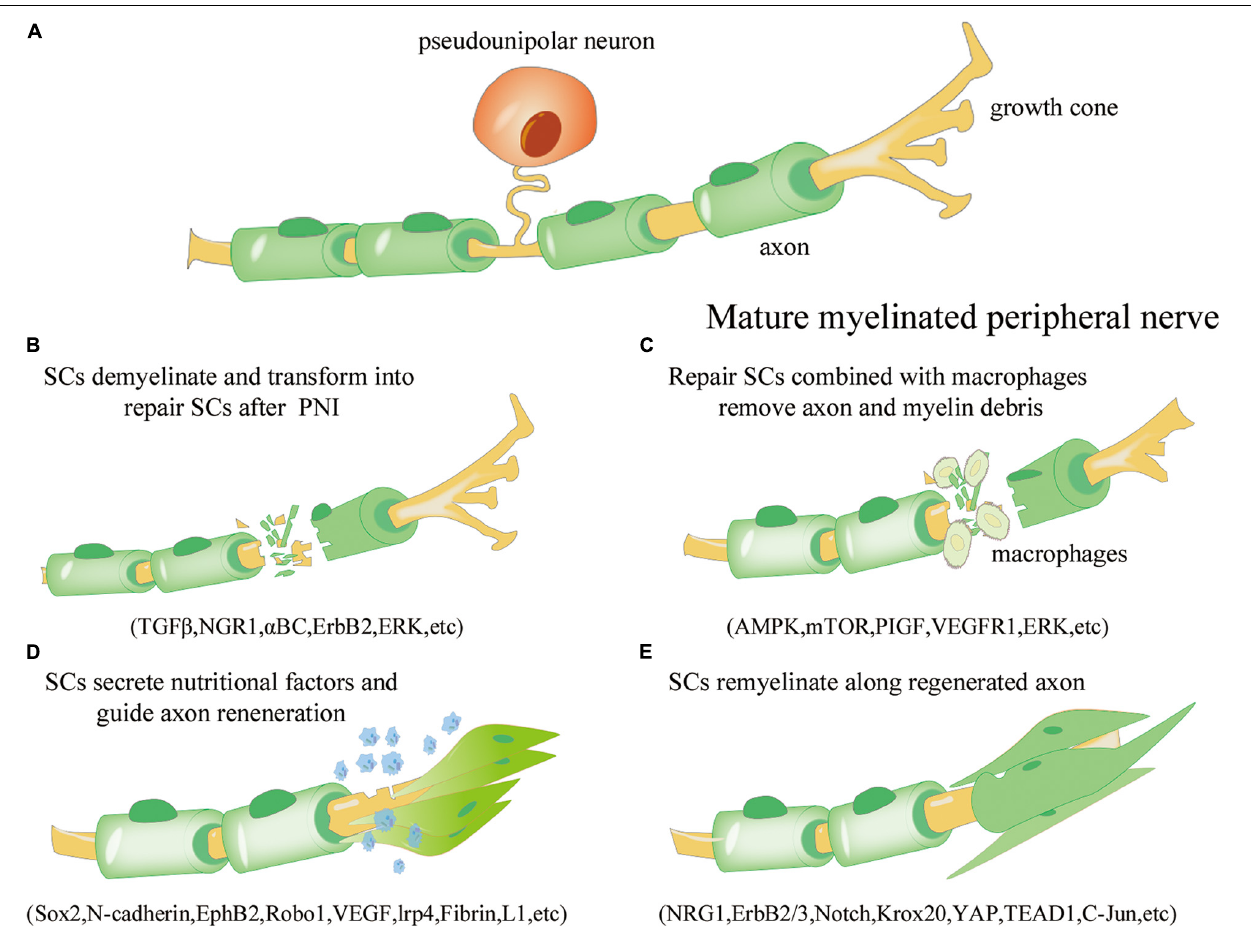
FIGURE 1 | Overview of the repair process of Schwann cells (SCs) after peripheral nerve injury. (A) Under normal physiological conditions, mature myelinated peripheral nerve processes (yellow) are surrounded by the myelin sheath formed by SCs (green). (B) Axonal rupture and myelin disintegration due to peripheral nerve injury. SCs are activated, dedifferentiate, and transform into the repair phenotype. The involved signaling pathways include transforming growth factor beta (TGF- β ), neuroregulin 1 (NGR1), α BC transporter, ErbB2, and extracellular signal receptor-kinase (ERK). (C) Repair SCs proliferate and fill the empty endoneurial canal, working with macrophages to remove axonal and myelin-derived debris; the involved signaling pathways include AMP activated protein kinase (AMPK), mammalian target of rapamycin (mTOR), placental growth factor (PIGF), vascular endothelial growth factor receptor 1 (VEGFR1), and ERK. (D) SCs are arranged along axons to form Büngner bands and secrete neurotrophic factors to improve the microenvironment and guide axon regeneration; the involved regulators include Sox1, N-cadherin, EphB2, Robo1, VEGF, lrp4, Fibrin, and L1. (E) SCs are re-myelinated along the regenerated axons to promote neural information transmission; the involved regulators include NRG1, ErbB2/3, Notch, Krox20, yes-associated protein (YAP), transcriptional enhance factor domain transcription factor 4 (TEAD1), and